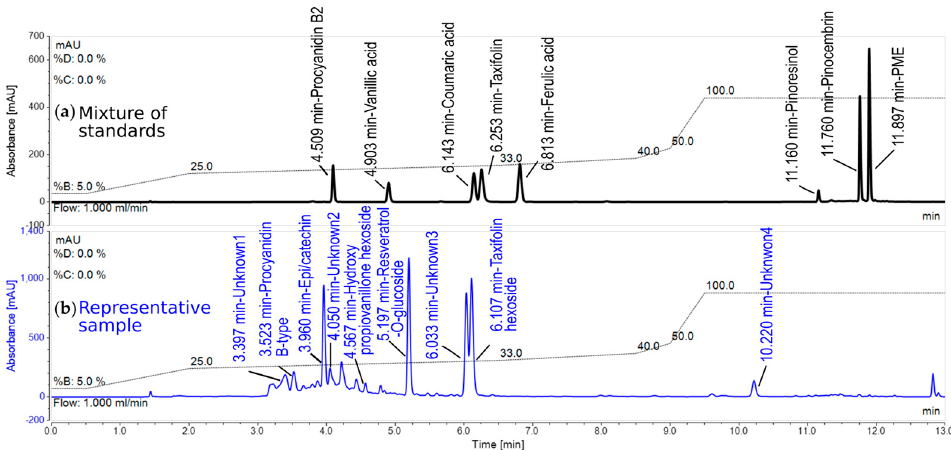
Figure 1. Annotated chromatogram depicting ( a ) mixture of authentic standards (top) and ( b ) a representative sample (bottom) (trace 280 nm). Peaks are labeled in the chromatogram. Ferulic acid, pinocembrin and pinosylvin monomethyl ether (PME) peaks were not considered for quantitation in the sample as their peak areas were either negligible or absent. Consequently, the mentioned compounds did not pass the peak area cut-off. Constitutive levels of p -coumaric acid were low and statistical analyses were not conducted (Figure S4). Gradient profile is overlaid on the chromatogram for easy visualization.